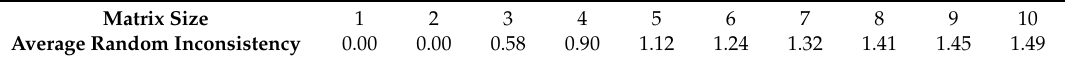
Table 2. Values of random inconsistency indices (adapted from Saaty